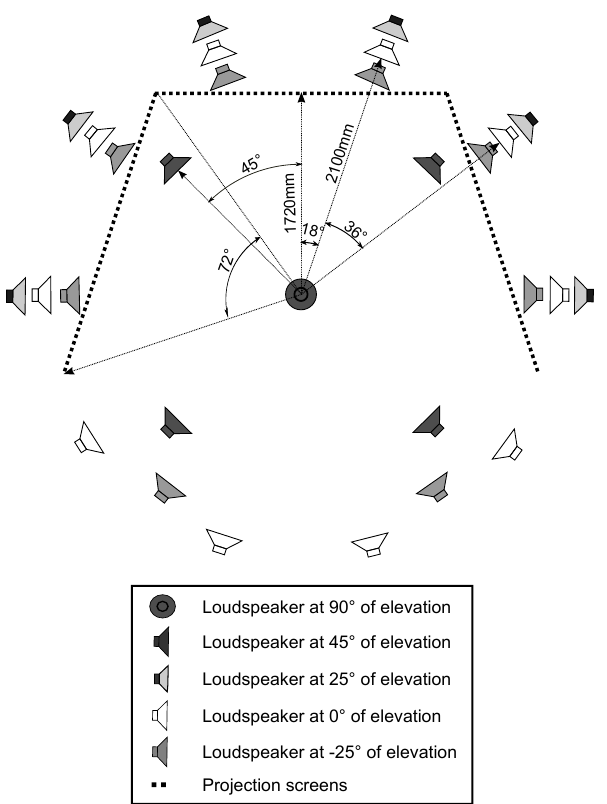
Figure 1 . A schematic drawing of the loudspeaker setup and the projection screens in the immersive audiovisual environ- ment. The observer is seated in the center of the Fig. 4: Loudspeaker setup for 3D audio reproduc- tion using DirAC. Each loudspeaker is located at the same distance from the listening position.